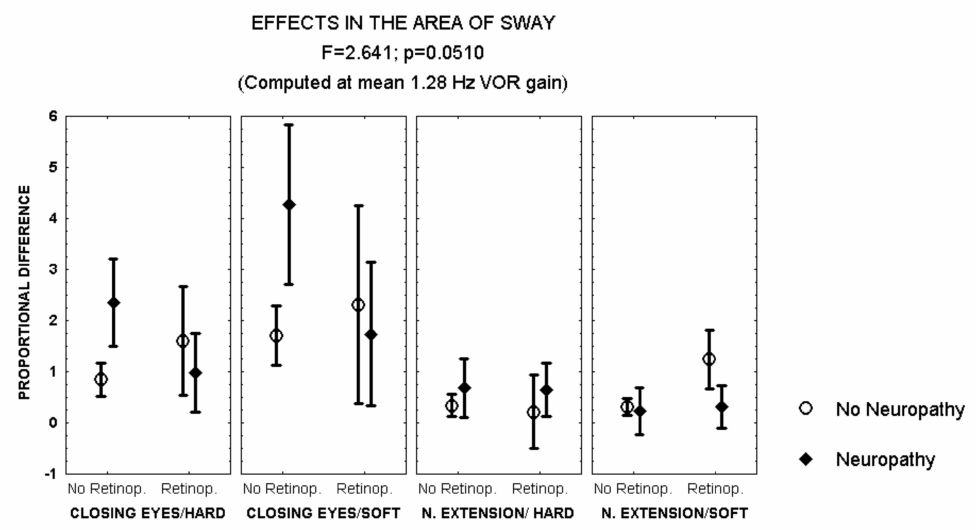
Figure 2. Mean and standard error of the mean of the proportional difference in the area of sway after closing the eyes or extending the neck, while standing either on hard or soft surface, according to the evidence of retinopathy or polyneuropathy. Statistical significance is provided according to the overall result of the MANCOVA, including the variables described in the Figure.